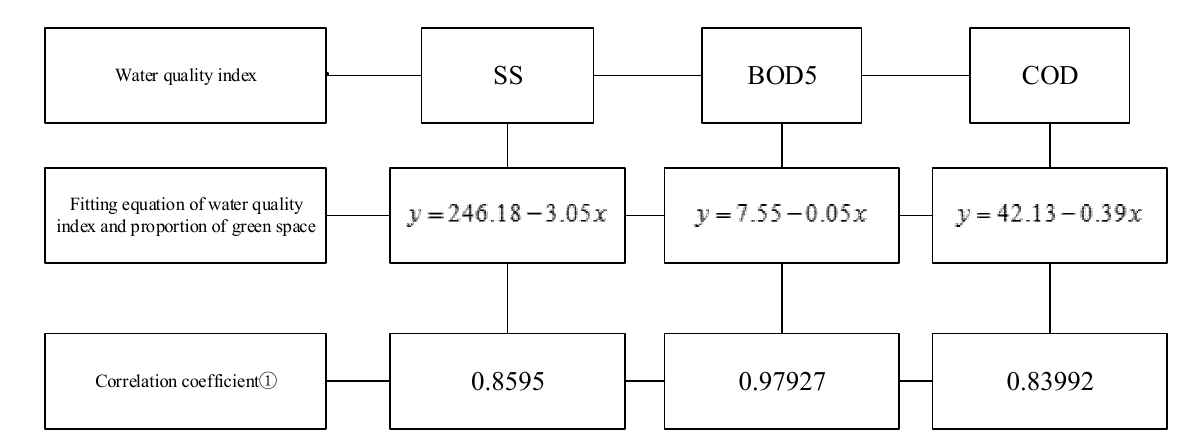
Figure 8. Fitting equation of runoff water quality. Note: ① When EIA ≈ 0, the regression predictions for suspended solids (SS), biochemical oxygen demand (BOD5), chemical oxygen demand (COD), and the proportion of green space. Note: ② the closer the correlation coefficient is to 1, the closer the fitting result is to the data to be fitted, and the better the fitting result is.